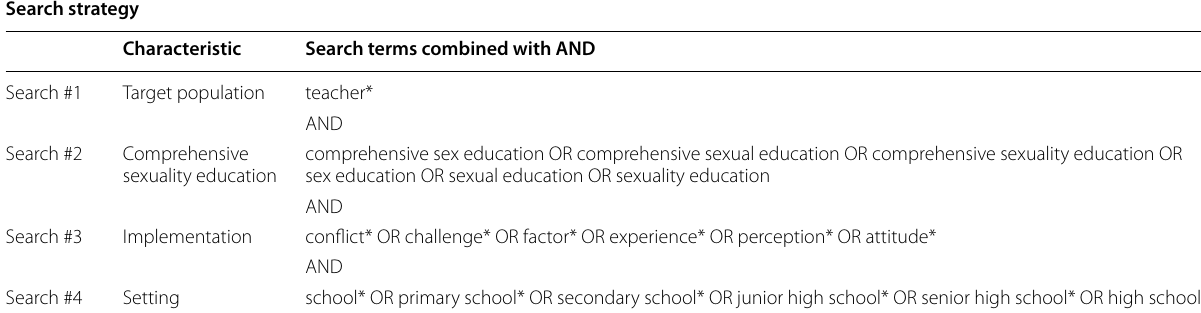
Table 1 Keywords and the combinations used in the search strategy Search